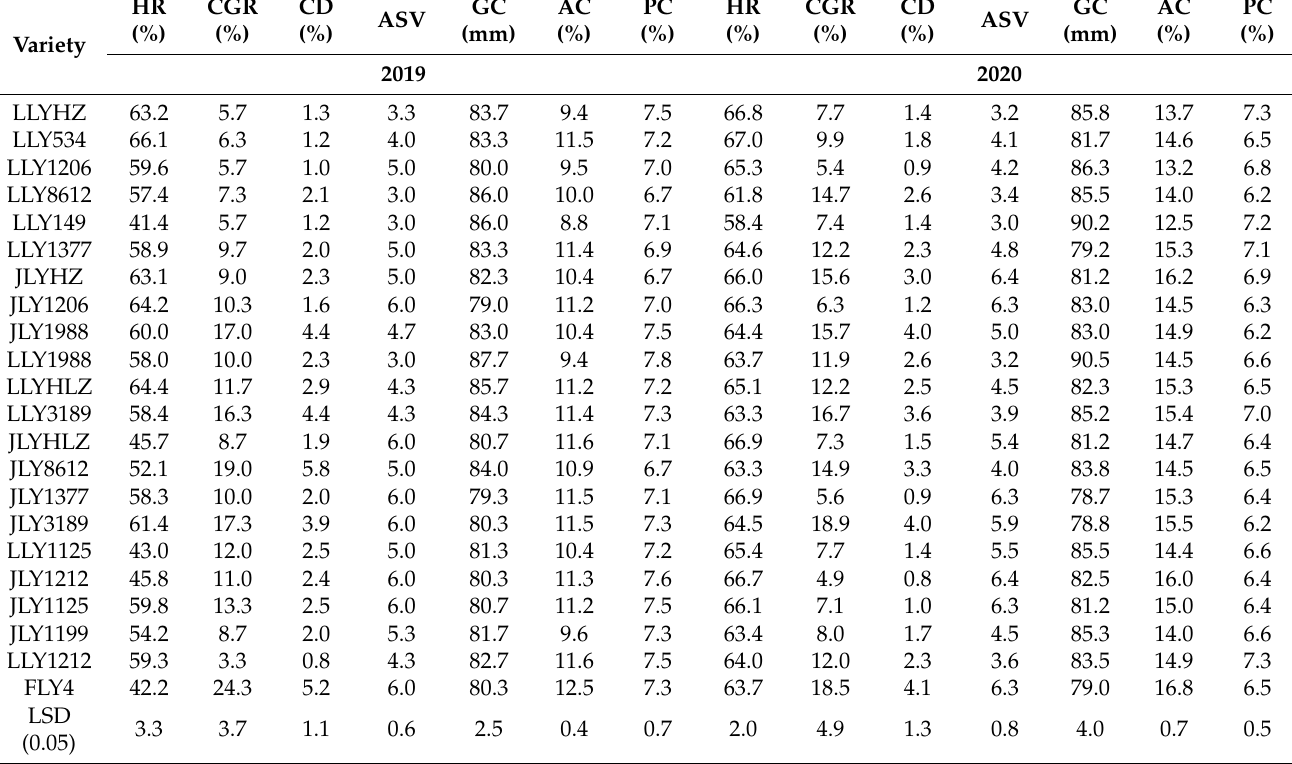
Table 2. The rice quality of tested hybrid rice varieties in 2019 and 2020.